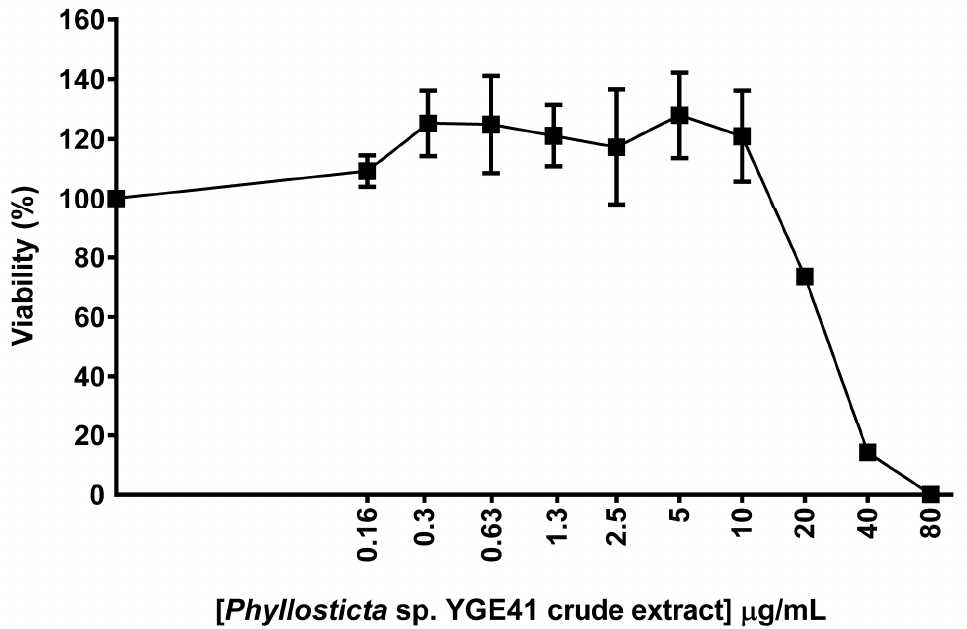
Figure 7. Phyllosticta sp. YGE41 crude extracts a ff ected the viability of biosensor cells. Thebiosensor cells were treated continuously with ethyl acetate crude metabolites from Phyllosticta sp. YGE41 for 48 h before viability determination. The viability assay was repeated with biologically independent replicates. Each point is shown as the mean ± standard deviation from one